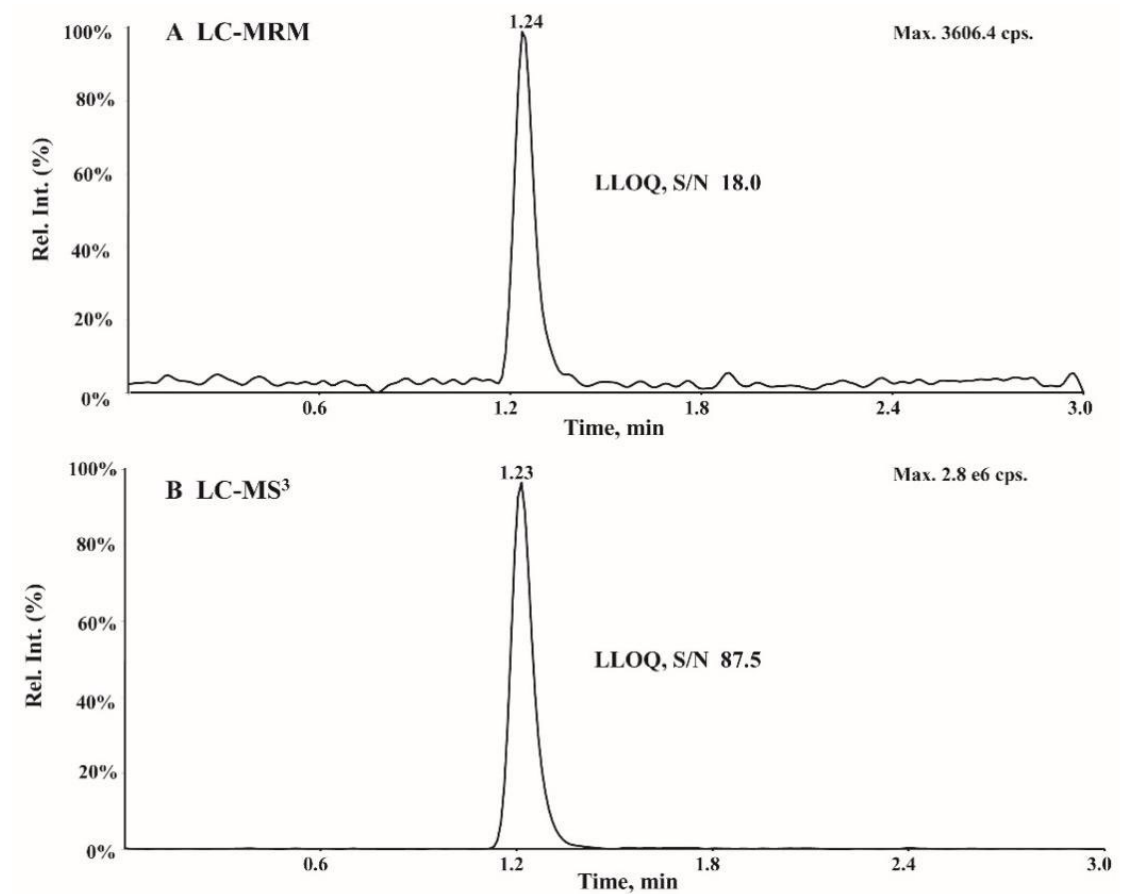
Figure 4. Representative chromatograms of AMT at the LLOQ (50 ng/mL) analyzed by ( A ) LC ‐ MRM and ( B ) LC ‐ MS 3 .